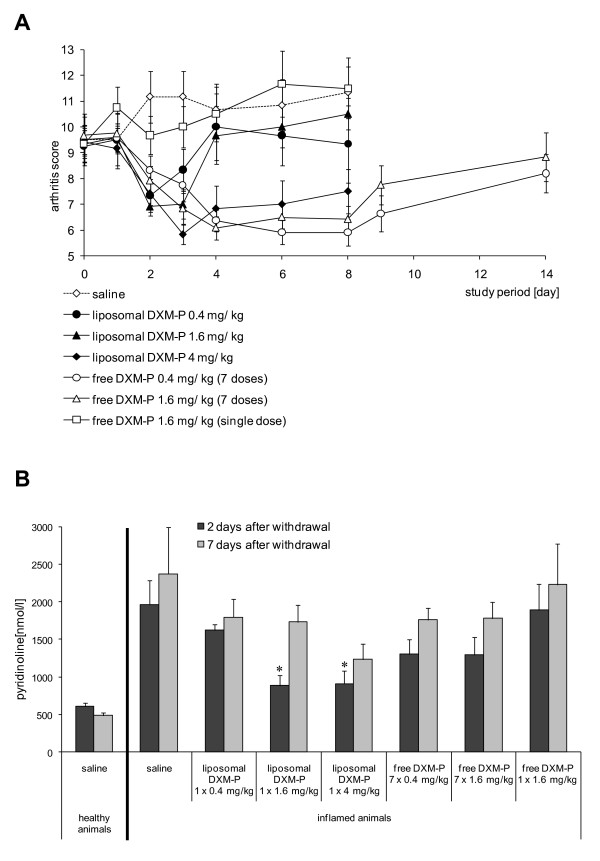
Therapeutic efficacy and persistence of liposomal dexamethasone phosphate. (a) Joint swelling was assessed by clinical scoring after a single injection of liposomal dexamethasone phosphate (DXM-P) (0.4 mg/kg, 1.6 mg/kg or 4 mg/kg) or after seven daily injections of free DXM-P (0.4 and 1.6 mg/kg). A single dose of free DXM-P at 1.6 mg/kg is also shown for comparison. Saline injections were used as controls. n = 12 for all groups; means ± standard error of the mean. (b) Urine pyridinoline levels 2 and 7 days after cessation of the treatment. *P ≤ 0.05 Mann-Whitney U test versus saline-treated inflamed animals. n = 6 for all groups; means ± standard error of the mean.